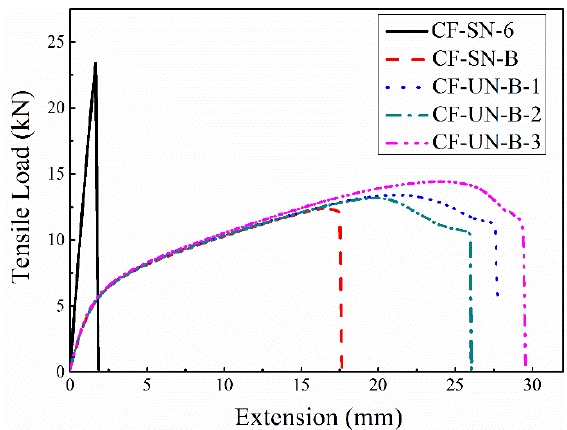
Figure 28. Comparison of the tensile load–displacement curves between specimens with a (cid:3399) 45° layer (CF ‐ SN ‐ B) and specimens with a 0°/90° layer (CF ‐ SN ‐ 6); the load–displacement curves of different non ‐ notched specimens are quite different when the specimens were loaded to more than 95% of the peak